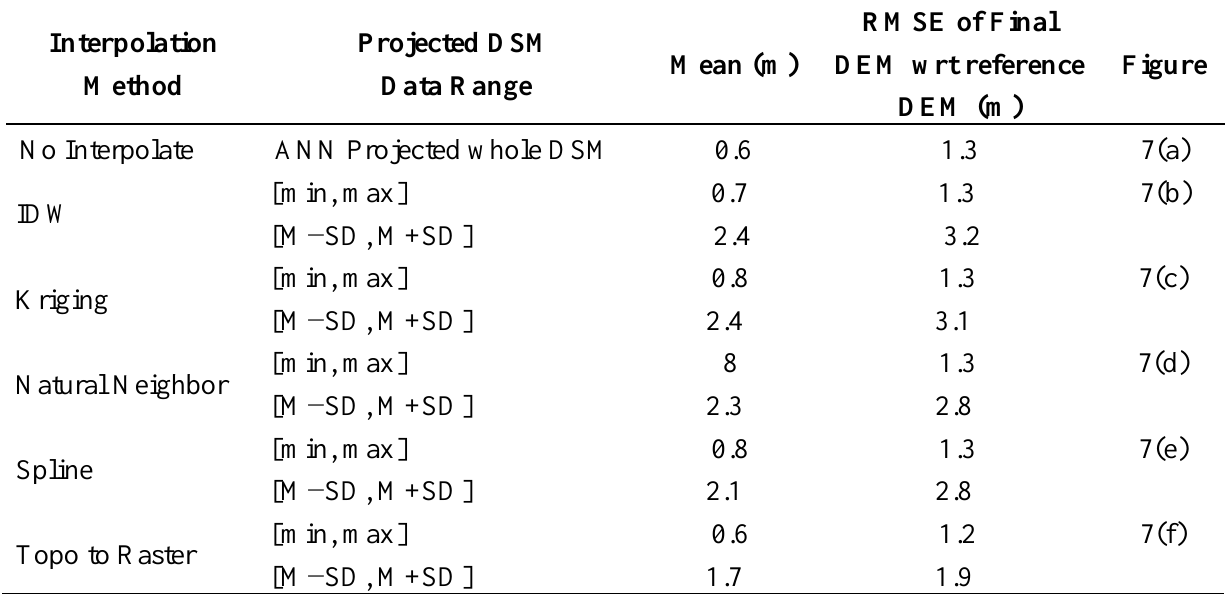
Table 3. Final DEMs accuracies after interpolation of projected DEMs data with perimeter DEM.